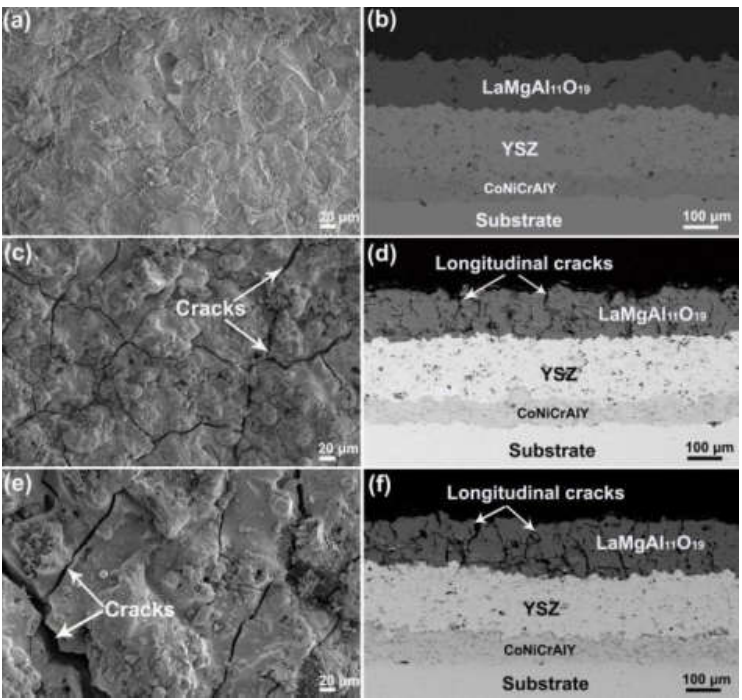
Figure 2. Surface and cross-sectional SEM images of sprayed and annealed coatings: ( a , b ) S0, ( c , d ) S1, and ( e , f ) S2.